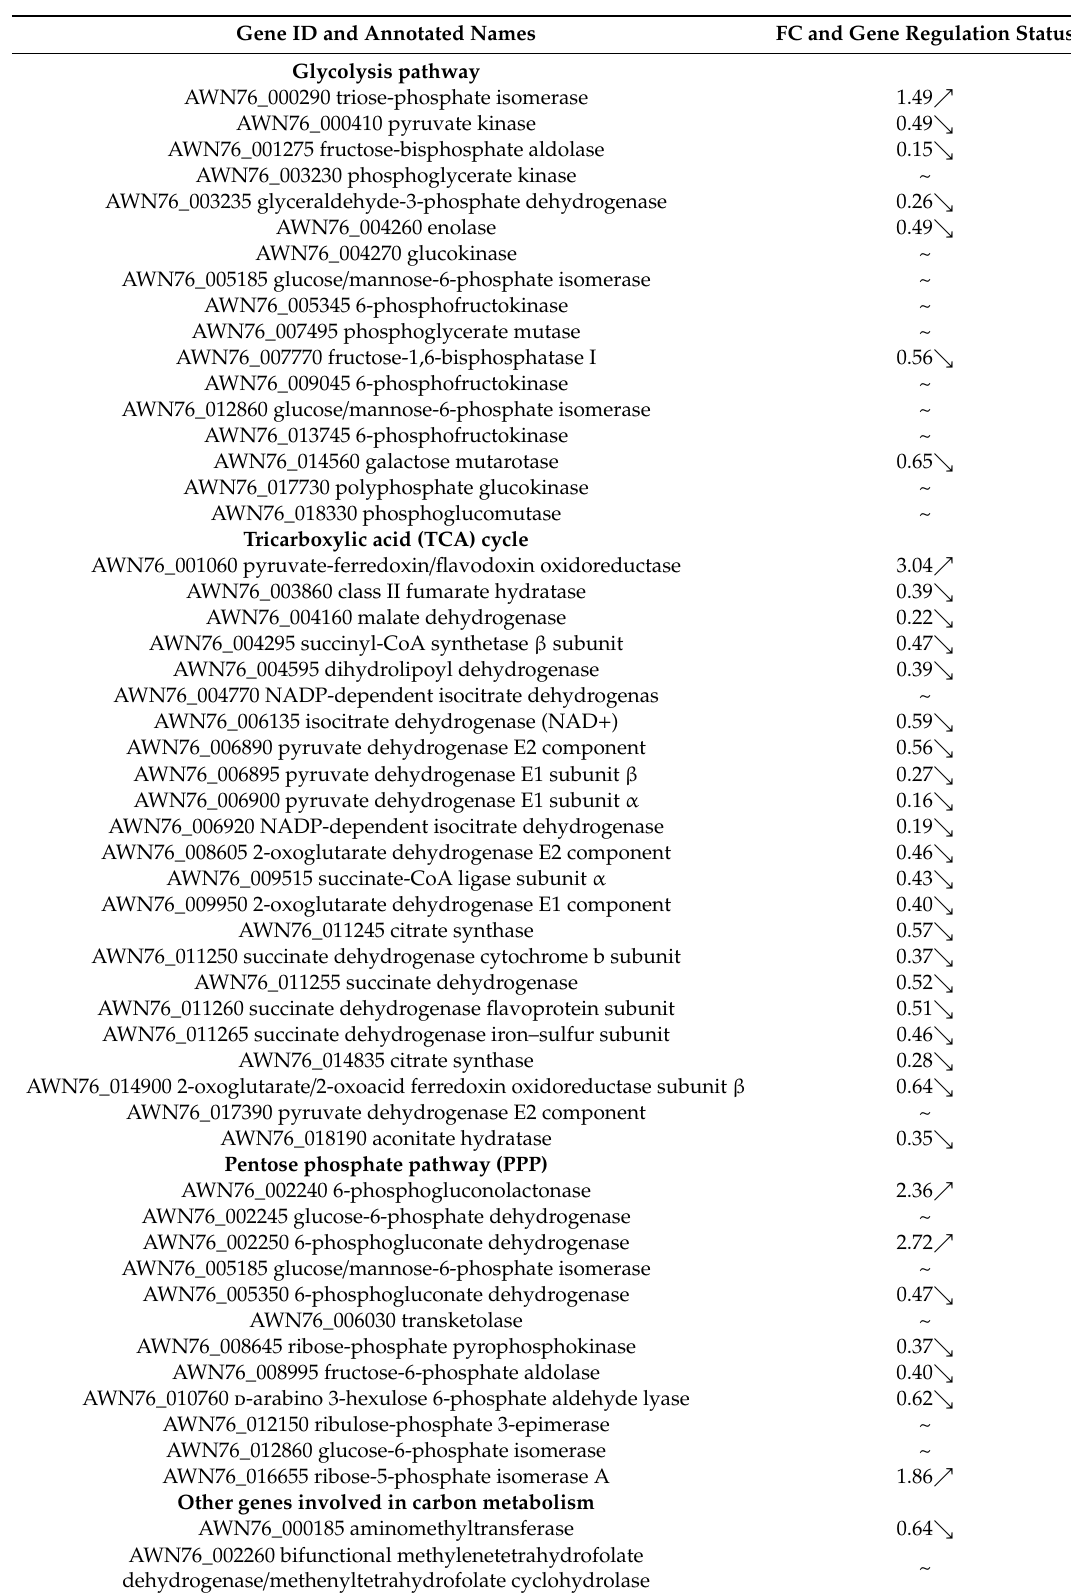
Table 7. Fold change of genes related to carbon metabolism when strain RA was cultivated in beechwood